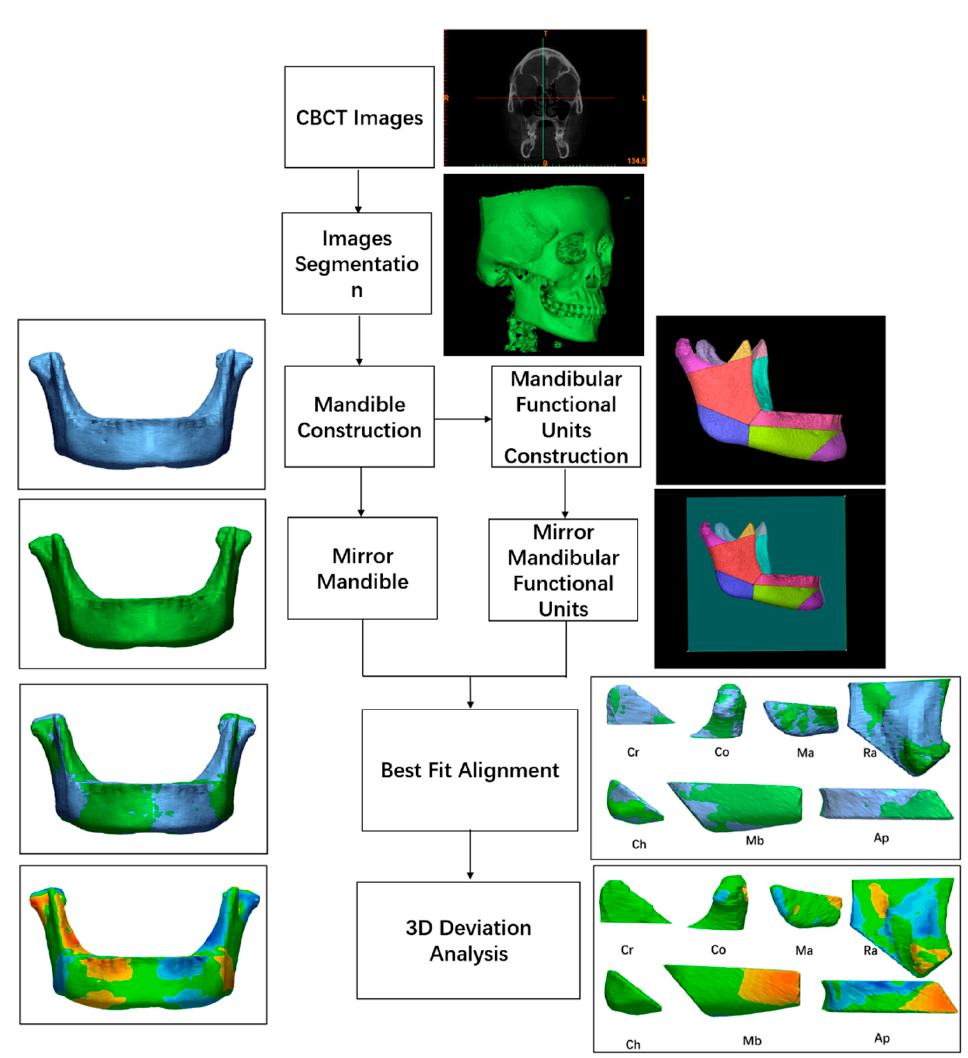
Figure 1. The flow chart of the whole image processing procedure.